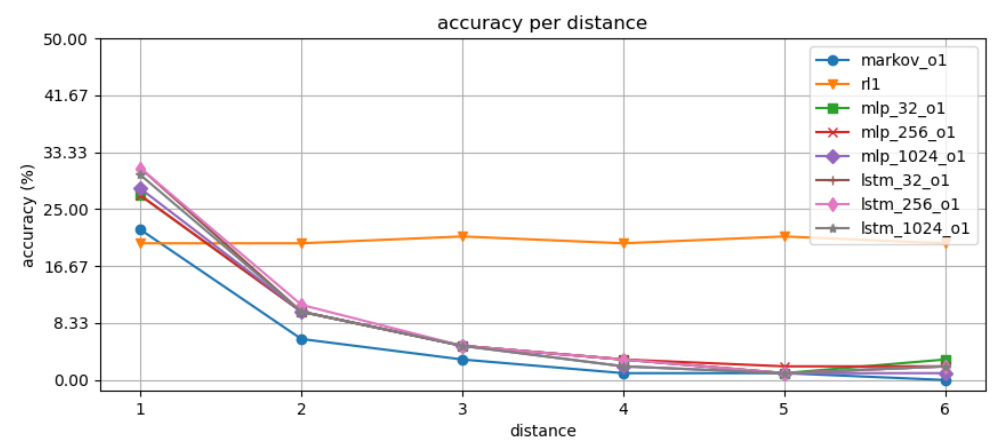
Figure 5. Accuracy comparison between the baseline and the RL-based